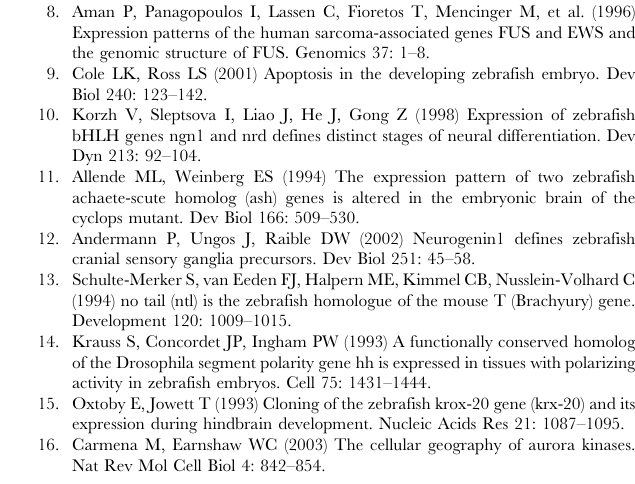
Table S2 Phenotype of Uninjected, Control MO, ewsr1a MO, Embryos. Number of atypical phenotypes: a= 2, b= 8, c= 2